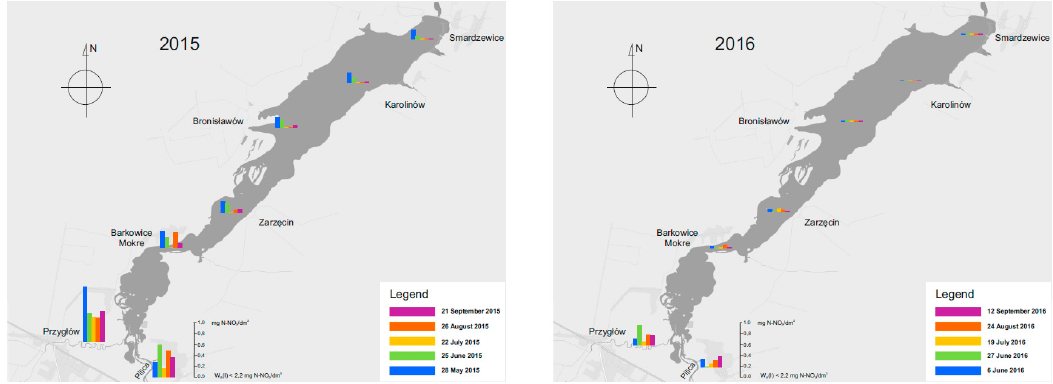
Figure 12. Changes in the concentration of nitrate nitrogen in the Sulejow Reservoir in 2015 and 2016.